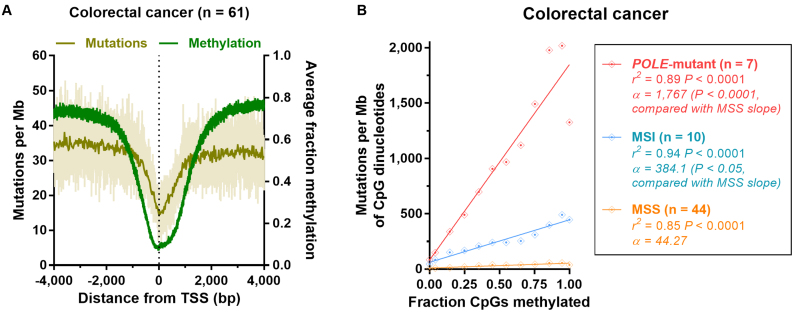
Association between mutation accumulation and methylation in colorectal cancer subtypes. (A) Colorectal cancer (n = 61) mutation profile and average methylation profile from normal colon whole genome bisulfite sequencing (WGBS) data, around transcription start sites (TSSs). Nucleotide-resolution mutation data (light beige), together with mutation data in 25 bp bins (dark beige) is shown. (B) Correlation between mutations per megabase (Mb) at CpG dinucleotides and fractions of CpGs methylated (using normal sigmoid colon tissue WGBS methylation data) across autosomes in Polymerase epsilon exonuclease domain mutation (POLE-mutant) colorectal cancers, those with microsatellite instability (MSI) or those that are microsatellite stable (MSS). Genome-wide data is binned for each colorectal cancer subtype (bins of 0.1 methylation), along with r2 and significance from Pearson's regression. The comparison of MSI and POLE-mutant slopes with MSS slopes was calculated by linear regression on binned data, with MSS as the reference factor.